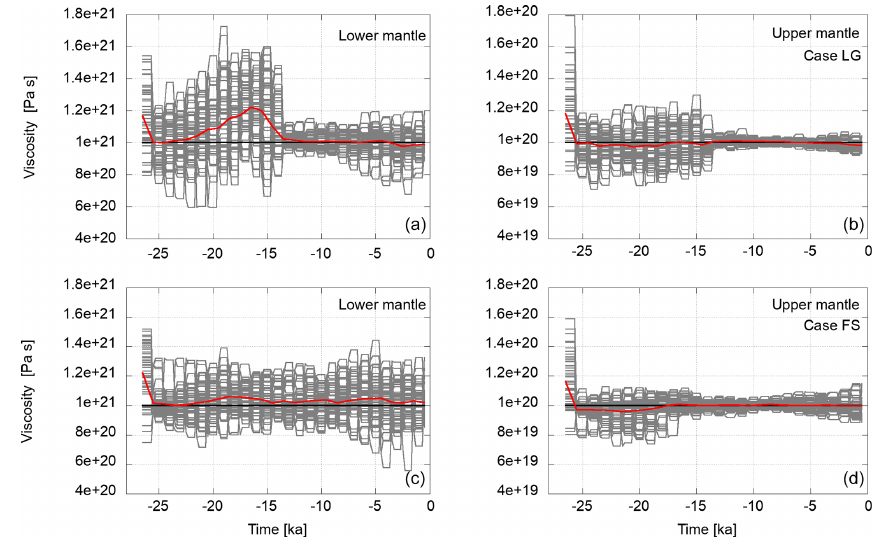
Figure 15. Variations in the viscosity in the course of the assimilation in the lower mantle (a, c) and the upper mantle (b, d) for test cases with regional data sets for North America and Greenland (a, b) and Fennoscandia (c, d) . The flat segments represent the viscosity values of an ensemble member during the forecast phase. When observations are available, a model state may be resampled and perturbed. This changes the viscosity values as shown. The horizontal black lines represent the viscosities of the reference experiment towards which the ensemble mean is expected to converge. The red lines are the weighted ensemble means. For the initial value, all members are weighted equally. Thereafter, they are weighted by the likelihood of the observations given the current member model